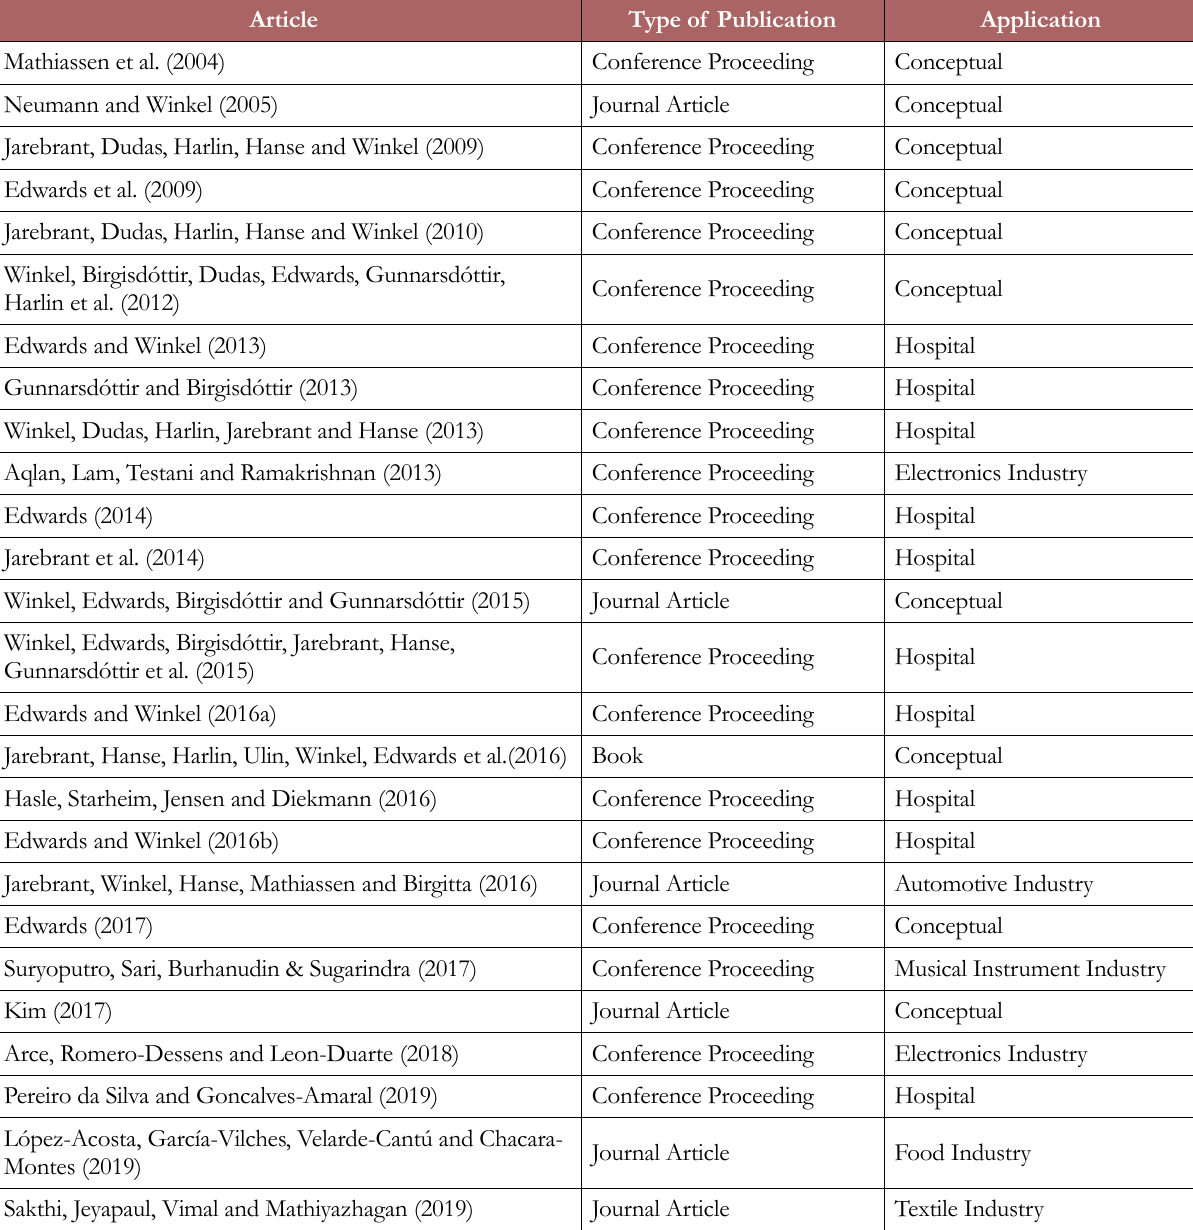
Table 1. List of articles that applied ErgoVSM, as well as their conceptual description